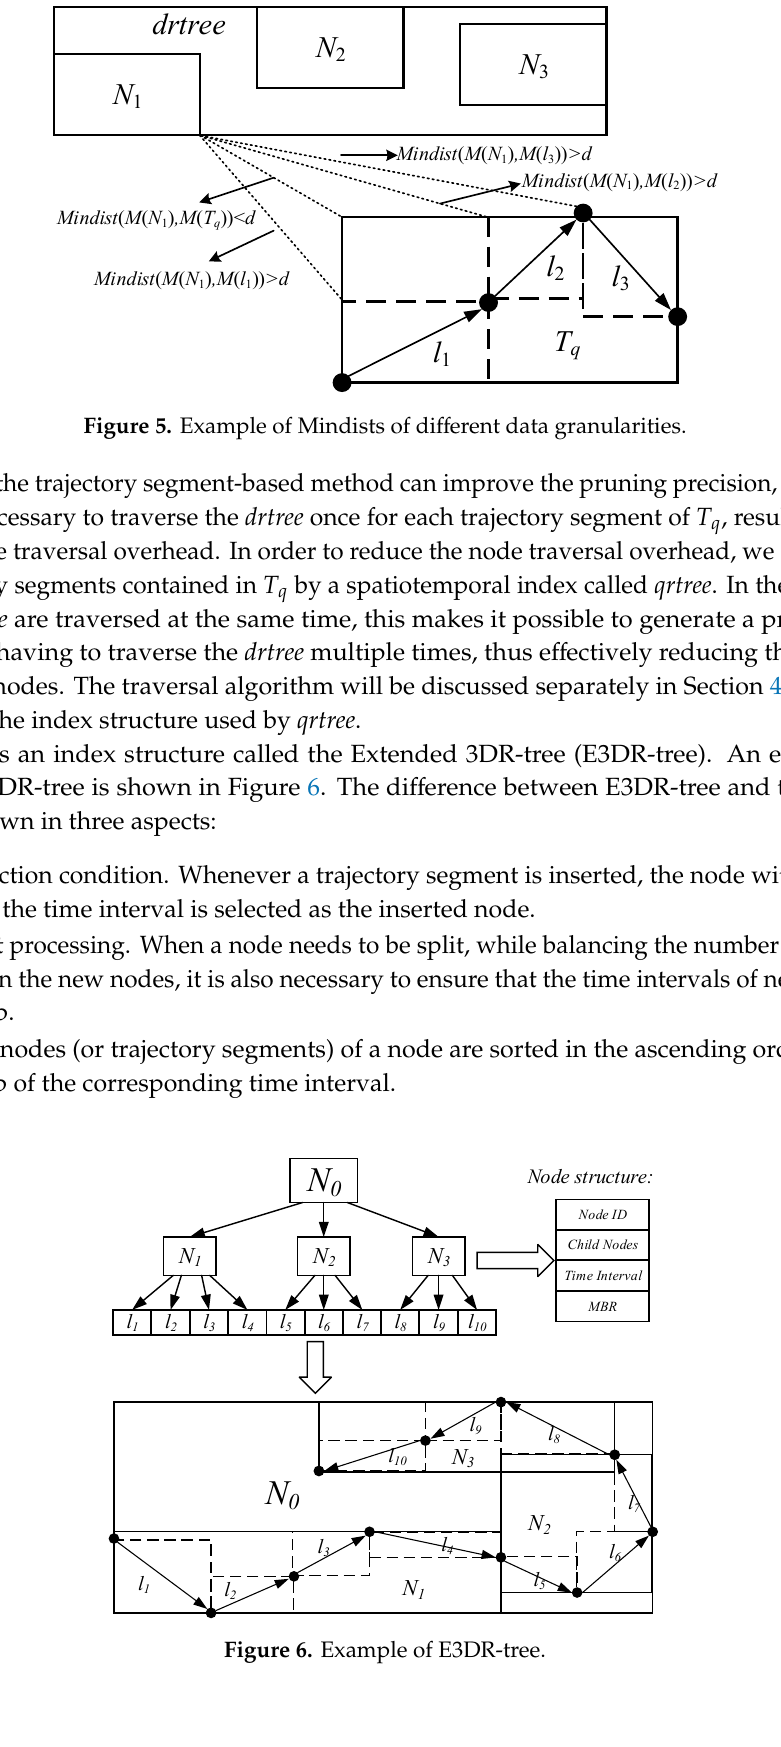
Figure 6. Example of E3DR-tree.